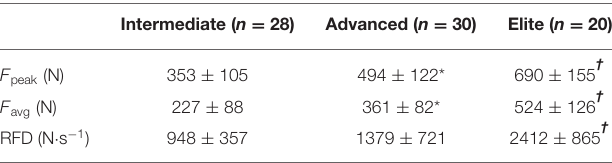
TABLE 2 | Absolute values from isometric pull-ups, percent difference between groups.